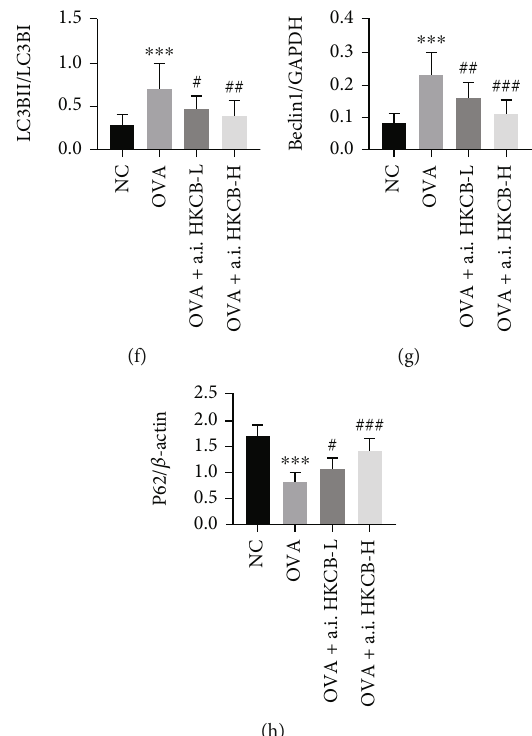
Figure 3: The e ff ect of aerosol inhalation of HKCB on autophagy in the lung tissues of allergic mice. (a) Expression levels of LC3B, Beclin1, and p62 in lung tissues, as examined by immunohistochemistry staining (magni fi cation 200x). (b – d) Expression scores of LC3B, Beclin1, and p62 in lung tissues. (e) Expression levels of LC3B, Beclin1, and p62 in lung tissues were examined using western blotting. (f – h) Relative expression levels of LC3BII/LC3BI, Beclin1, and p62 in lung tissues. ∗ P < 0 : 05 , ∗∗ P < 0 : 01 , and ∗∗∗ P < 0 : 001 versus the NC group; # P < 0 : 05 , ## P < 0 : 01 , and ### P < 0 : 001 versus the OVA group. a.i.: aerosol inhalation; CB: Clostridium butyricum ; HKCB: heat- killed